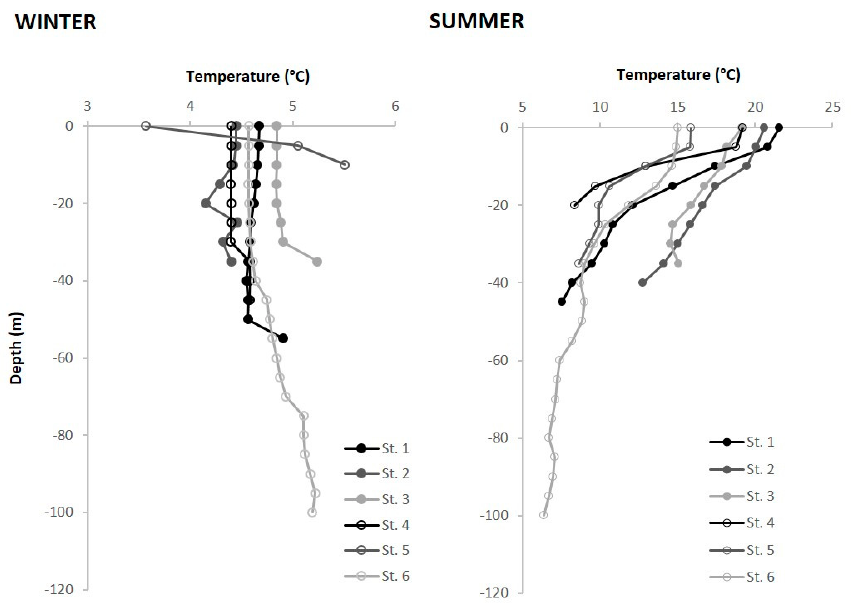
Figure 9. Temperature vertical profiles in winter and summer at stations 1 to 6.